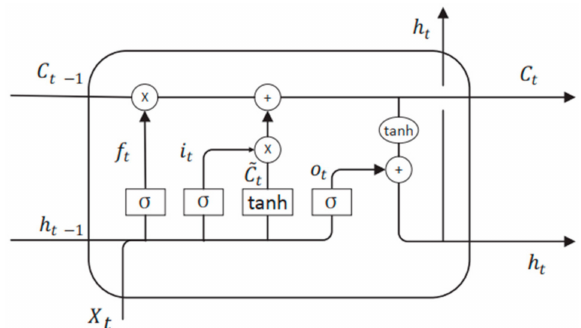
Figure 1. Architecture of a long short-term memory (LSTM)